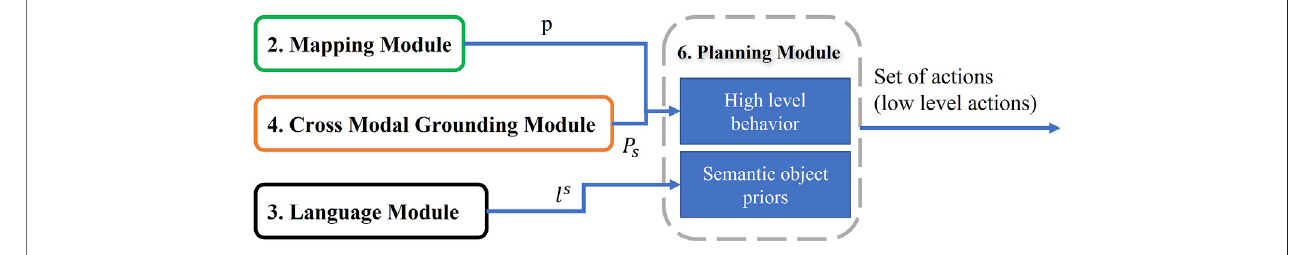
Frontiers in Robotics and AI |